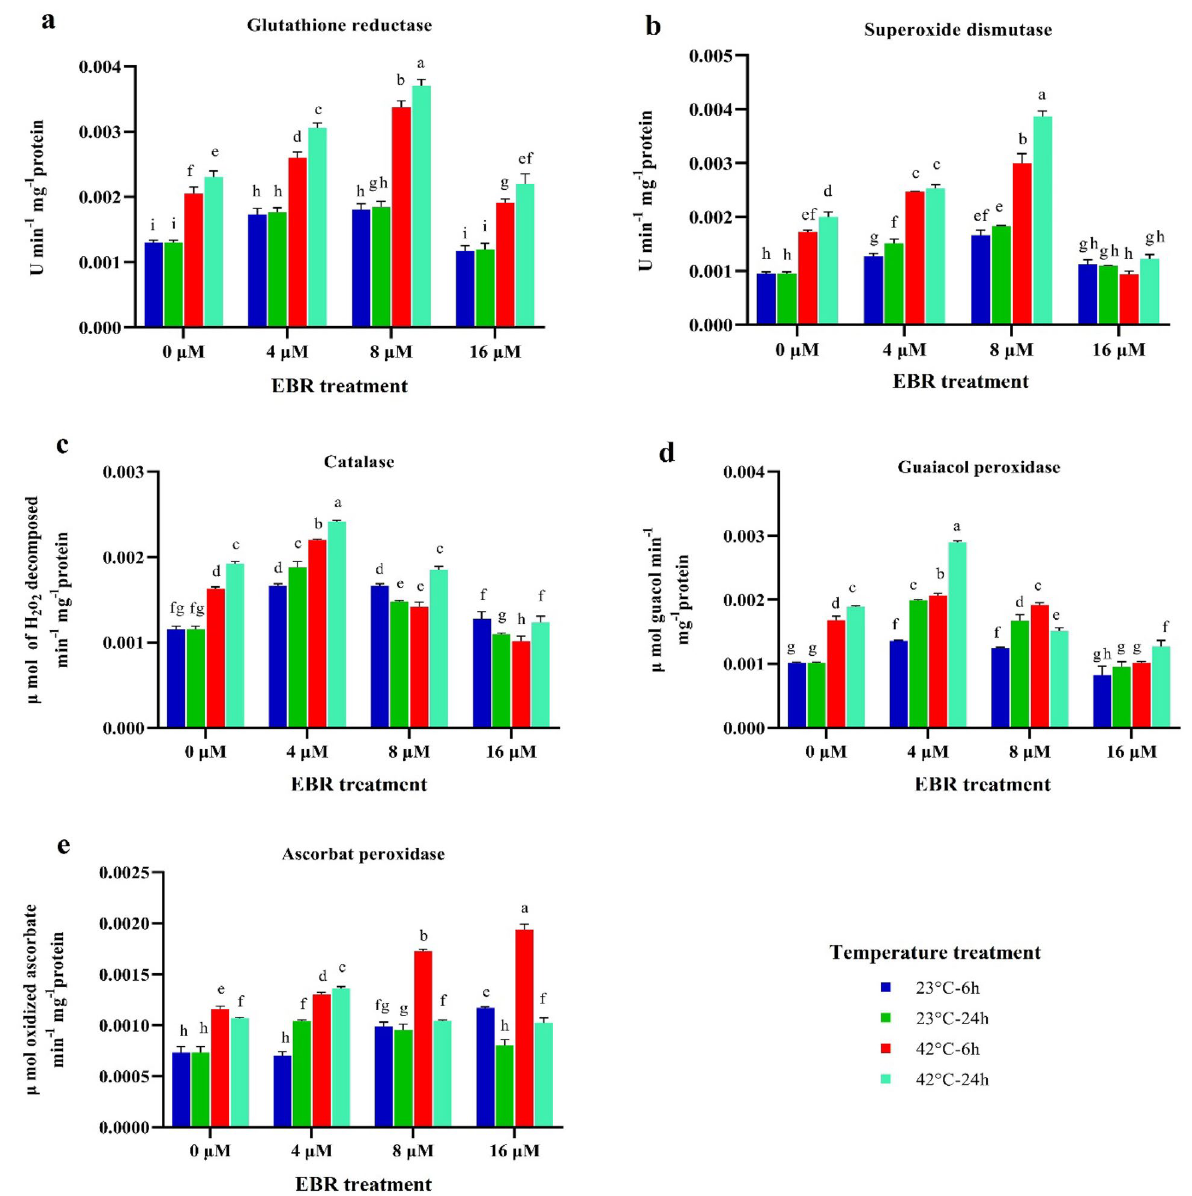
Figure 3. The effects of temperature, harvesting times, and different levels of EBR on superoxide dismutase ( a ), glutathione reductase ( b ), catalase ( c ), guaiacol peroxidase ( d ) and ascorbate peroxidase ( e ). Duncan method at a 1% probability level was applied to compare mean values. The columns having similar letters had no significant EBR during stress enhanced the content of endogenous abscisic acid (Fig. 5). The highest content of abscisic acid was 33 ng g −1 FW applying 8 μM of EBR at 24 h under high-temperature stress. Besides, the endogenous content of auxin rose significantly after the use of EBR. (Fig. 5). Auxin content increased by 40% in response to EBR application (8 μM) under high-temperature at 24 h in comparison with the untreated samples (Fig. 5). Gene expression profiles, and diosgenin content. The squalene synthase ( SQS ) gene expression was significantly reduced under normal temperature (23 °C), 6 and 24 h after using different concentrations of EBR compared to the control (23 °C without EBR). Under high-temperature stress at both 6 and 24 h without EBR treatment, the expression of this gene rose by 2.7-fold and fourfold in relation to the control, respectively (Fig. 6). Besides, the squalene epoxidase ( SEP ) expression significantly lowered under the control (23 °C) after using dif- ferent levels of EBR, in contrast, its expression under high-temperature stress without EBR the application rose compared to the control. The SEP expression increased by 2.8-fold after the onset of the high-temperature stress along with the application of EBR (4 μM, at 24 h) (Fig. 6).